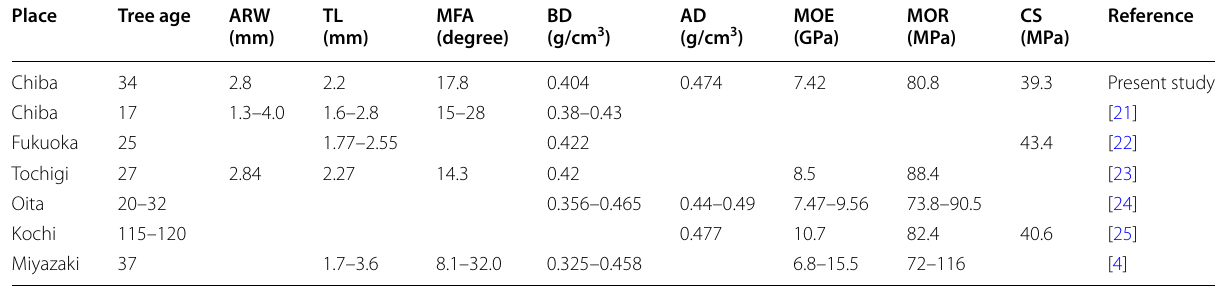
Table 3 Comparison of wood properties of C. obtusa grown in Japan